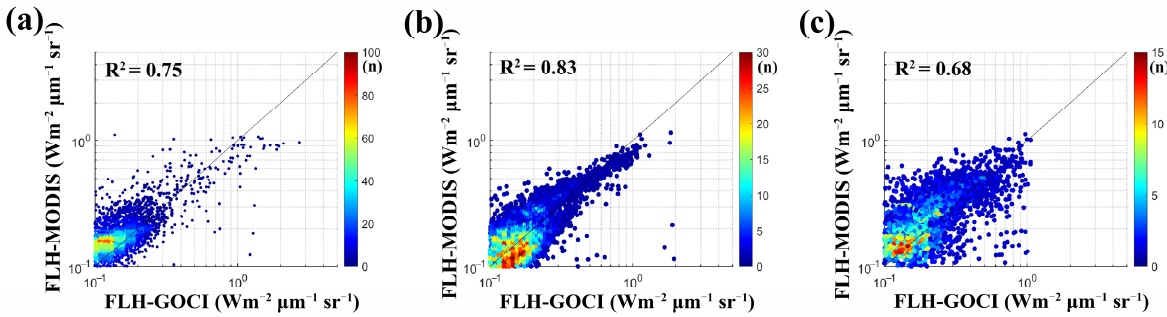
Figure 9. Comparison of improved GOCI FLH results with improved MODIS FLH results.